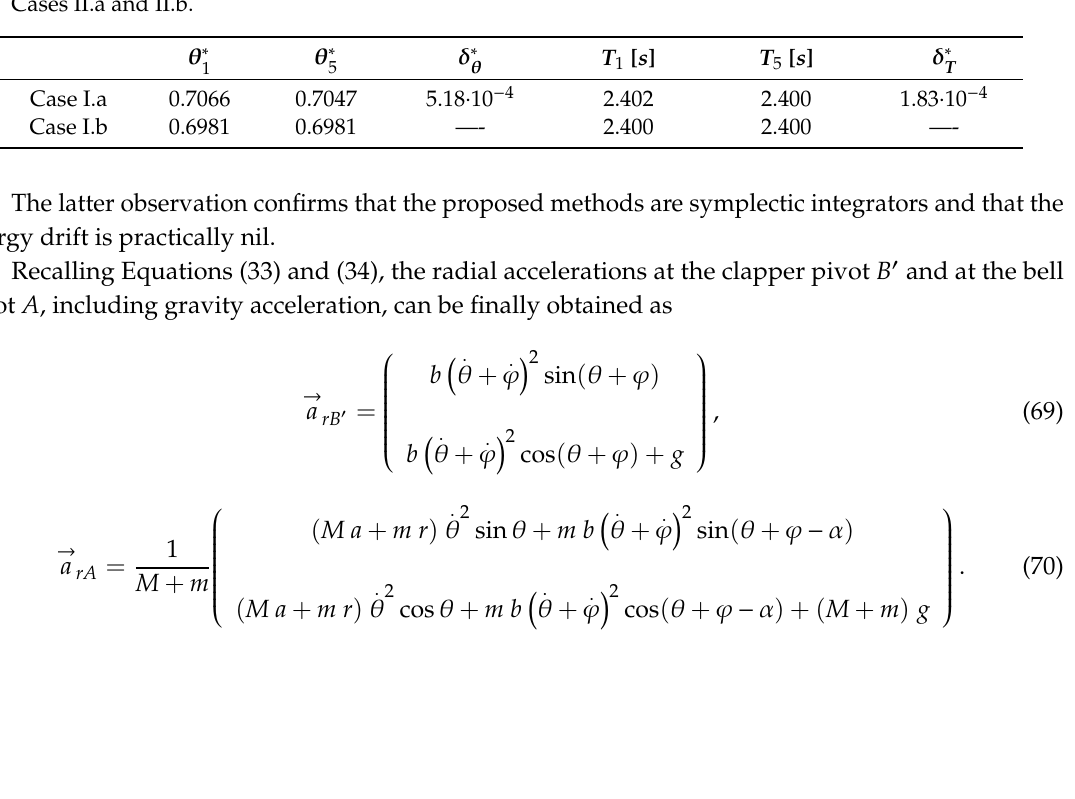
and T ∗ and apparent logarithmic decrements in 5 1